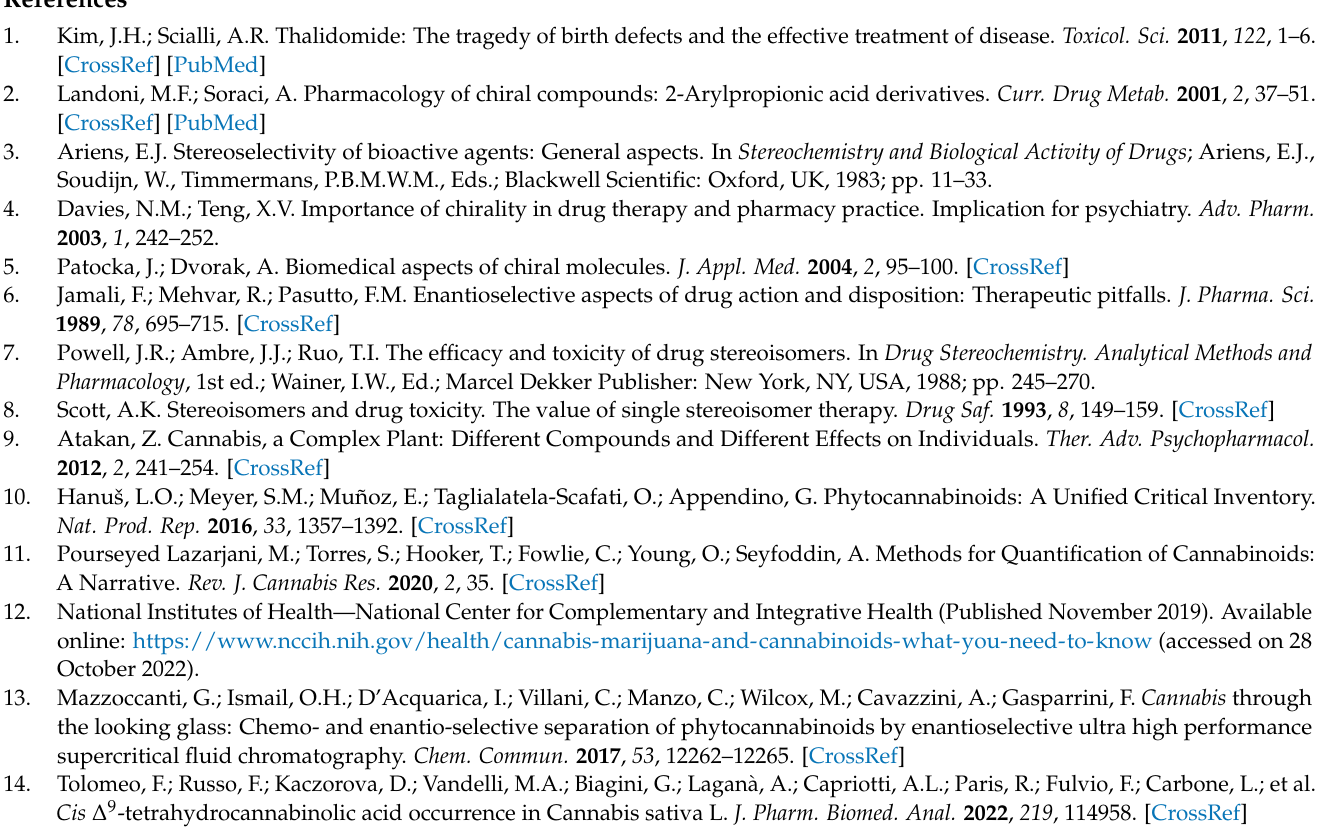
Figure S9: Separation of CBCA on CHIRALPAK ® IC-3 with Hex-DCM-TFA = 80-20-0.1 ( v / v / v ); Figure S10: Separation of CBCA on CHIRALPAK ® IK-3 with Hex-MtBE-TFA = 80-20-0.1 ( v / v / v ); Figure S11: Separation of CBCA on CHIRALPAK ® IK-3 with Hex-EtOAc-TFA = 90-10-0.1 ( v / v / v ); Figure S12: Separation of CBL on CHIRALPAK ® IBN-3 with Hex-EtOAc = 90-10 ( v / v ); Figure S13: Separation of CBL on CHIRALPAK ® IBN-3 with Hex-MtBE = 80-20 ( v / v ); Figure S14: Separation of CBL on CHIRALPAK ® IC-3 with Hex-DCM = 80-20 ( v / v ); Figure S15: Separation of CBL on CHIRALPAK ® IG-3 with Hex-DCM = 80-20 ( v / v ); Figure S16: Separation of CBL on CHIRALPAK ® IG-3 with Hex-EtOAc = 90-10 ( v / v ); Figure S17: Separation of CBL on CHIRALPAK ® IG-3 with Hex-MtBE = 80-20 ( v / v ); Figure S18: Separation of CBLA on CHIRALPAK ® IC-3 with Hex-DCM-TFA = 80-20-0.1 ( v / v / v ); Figure S19: Separation of CBLA on CHIRALPAK ® IG-3 with Hex-EtOAc-TFA = 90-10-0.1 ( v / v / v ); Figure S20: Separation of CBLA on CHIRALPAK ® IK-3 with Hex-MtBE-TFA = 80-20-0.1 ( v / v / v